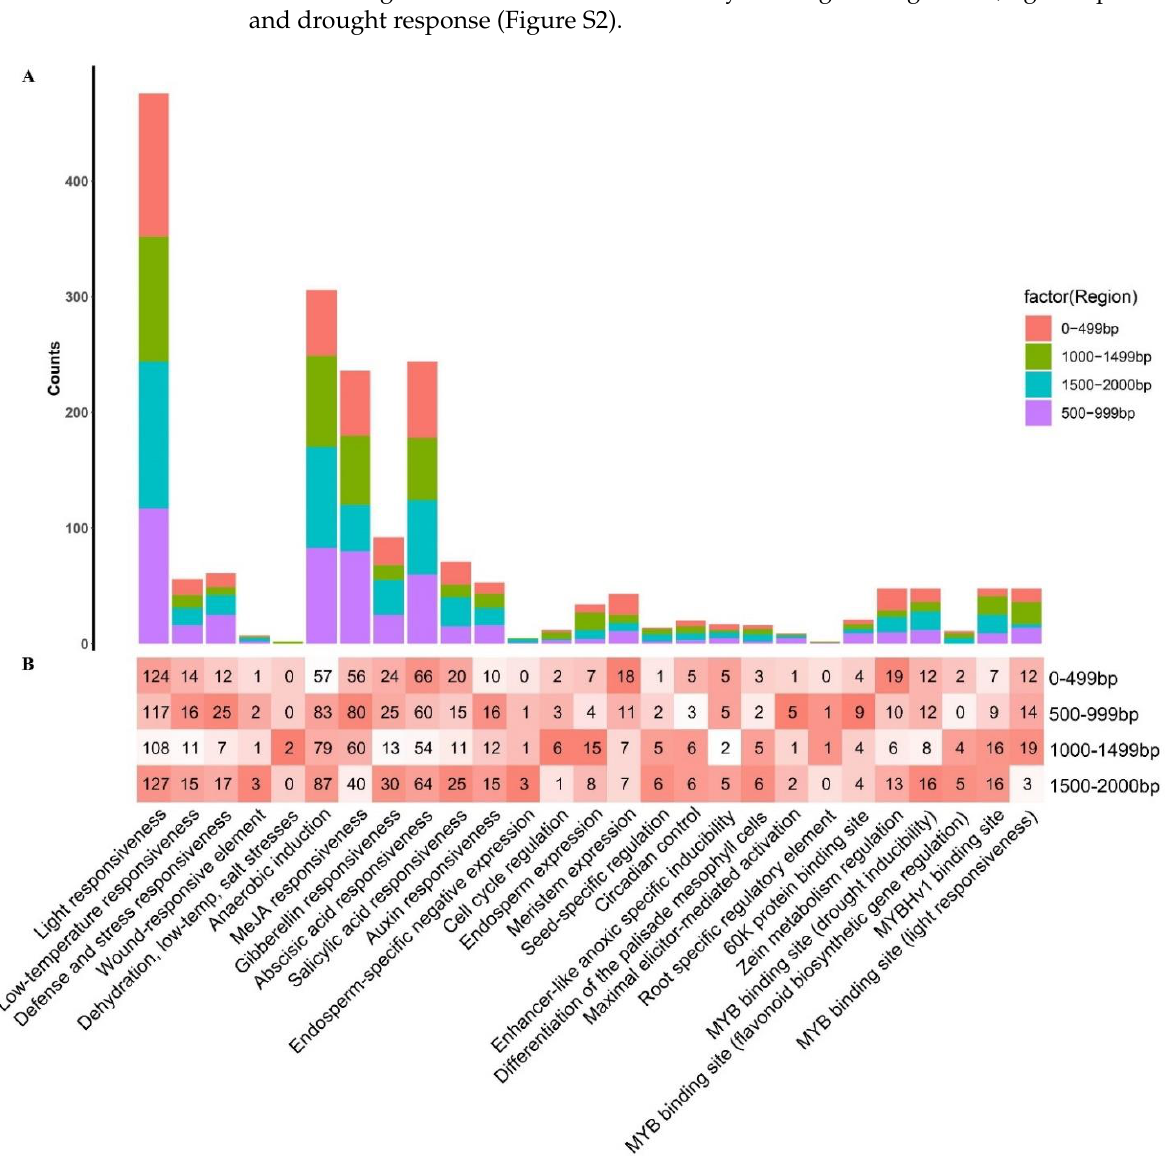
Figure 3. Prediction of the cis-acting elements of promoters of 128 R2R3-MYB genes in C. oleifera . ( A ) The stacked bar chart represents the sum of the cis-acting elements in each category. ( B ) Statistical analysis of 27 categories of cis-acting elements in 4 regions of promoters (0 – 499 bp, 500 – 999 bp, 1000 – 1499 bp, and 1500 – 2000 bp). The colors and numbers in the grid indicate the number of these cis-acting elements in the region. The darker the red color in the grid, the greater the number of cis-acting elements in that region than in other